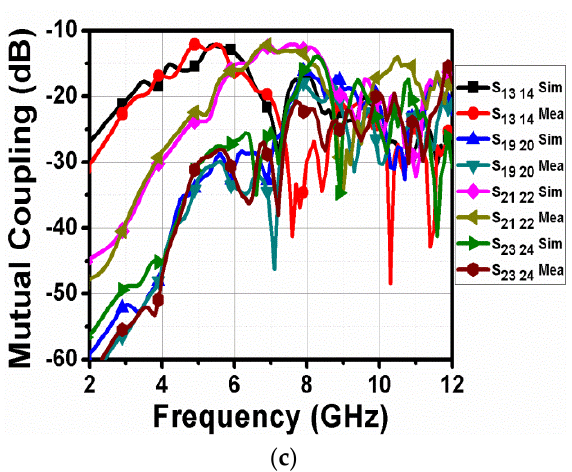
Figure 22. Mutual coupling between identical communication antennas ( a ) S 29 , S 34, S 45 , and S 56 ( b )